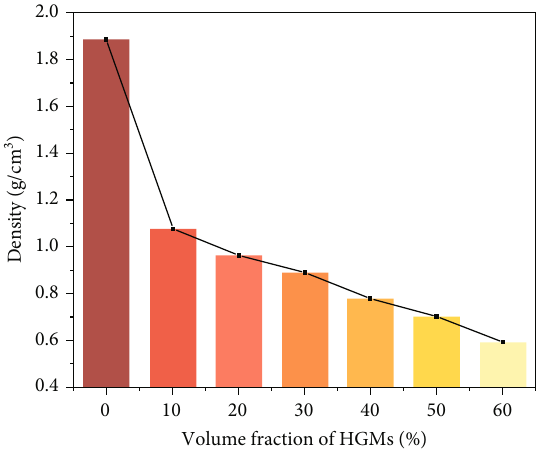
Figure 11: Densities of the HGM/EP composite insulation materials with the indicated HGM volume fractions.